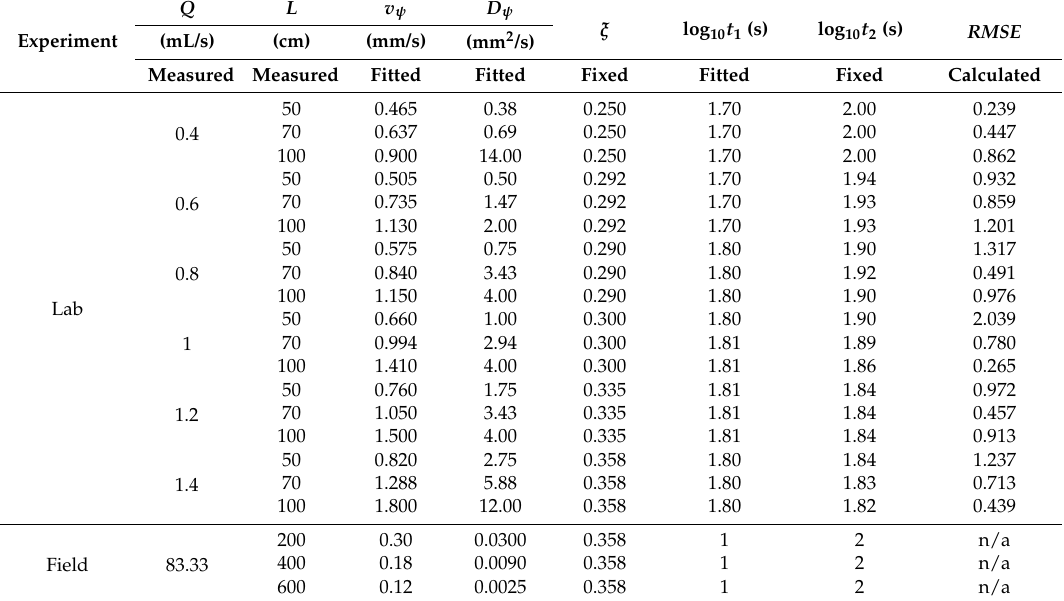
Table 7. The best-fit parameters for the continuous time random walk (CTRW) model. In the legend, v ψ is the CTRW transport velocity, which can be different from the average pore velocity v ; D ψ is the dispersion coefficient with the subscript ψ indicating CTRW interpretation; ξ is the power-law exponent; t 1 is the mean transition time; and t 2 is the truncation time scale. ξ is converted from γ in the tt-fADE model (10) and (11), and t 2 is converted from λ in the tt-fADE model. Q L v ψ D Experiment